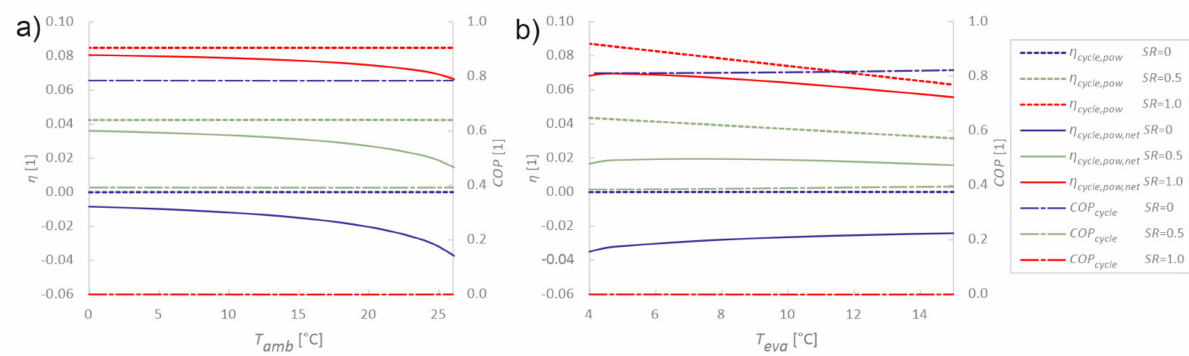
Figure A2. COP and gross and net APCC system efficiency at ( a ) varied ambient temperature and ( b ) varied evaporator